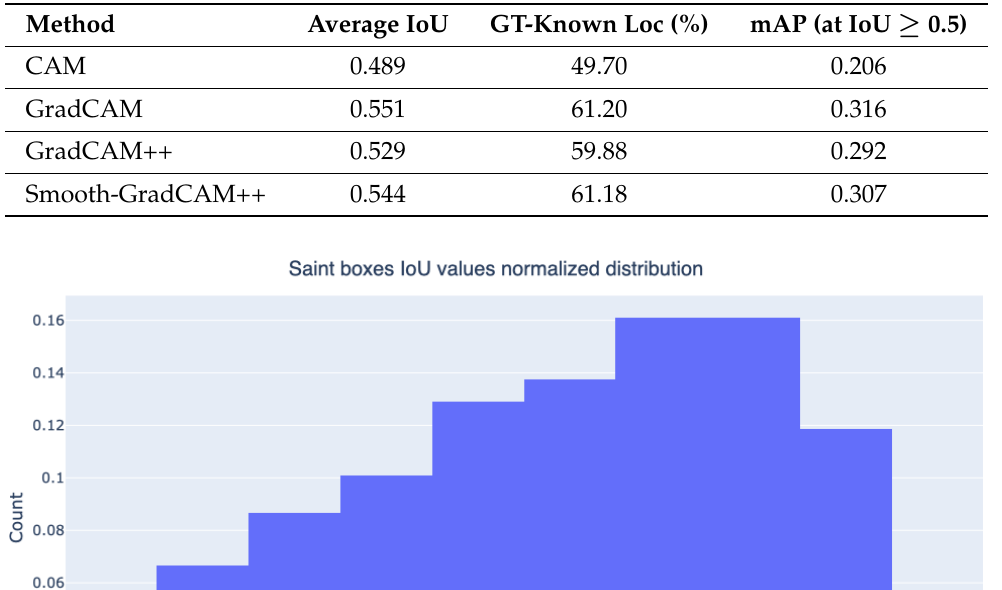
Table 3. Average IoU, GT-Known accuracy and mAP values for the whole Saint bounding boxes estimated with the four analyzed class activation map techniques. The values are calculated with an activation threshold equal to 0.05.